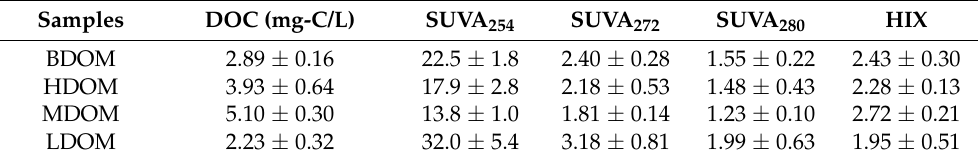
Table 1. Dissolved organic carbon (DOC) concentrations and UV/vis and fluorescence indicators of size-fractioned dissolved organic matter (DOM) and BDOM ( n =